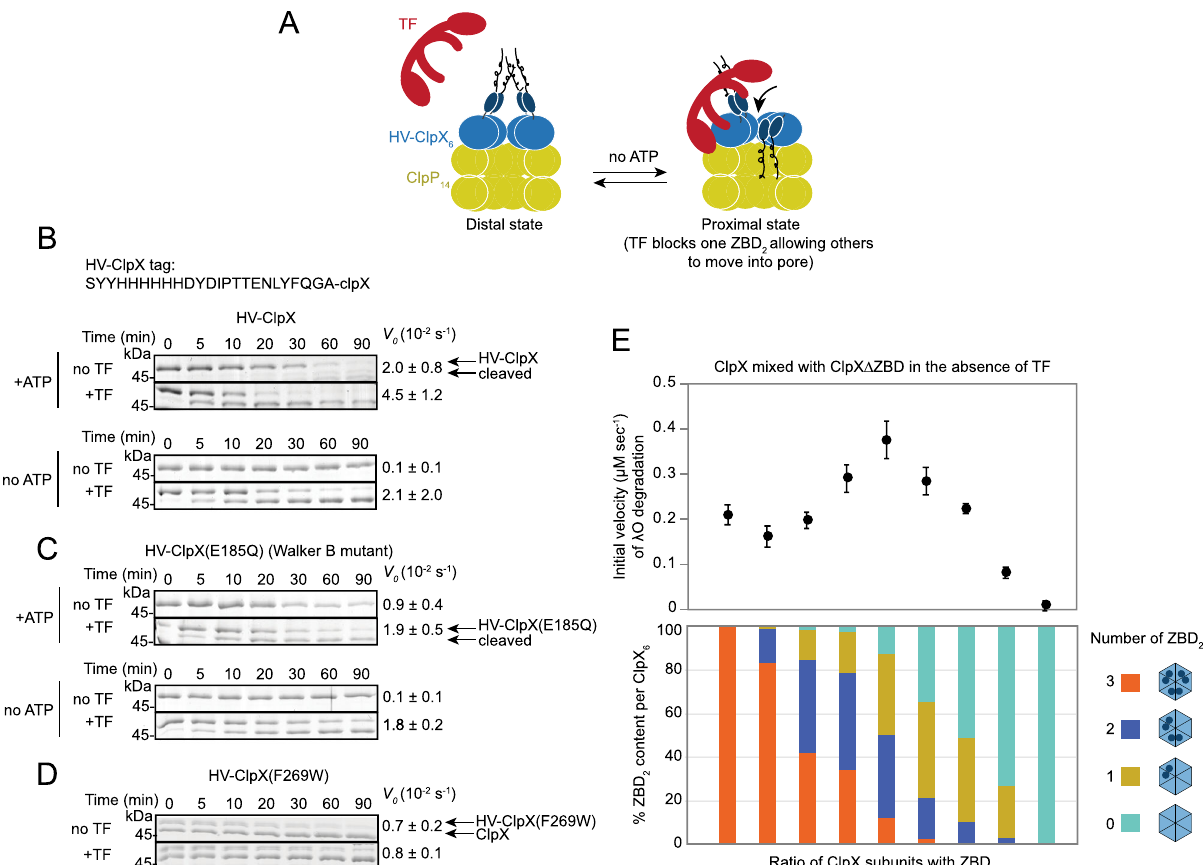
Fig. 3 TF enhances ClpXP-dependent degradation by modulating the movement of ZBD. A Model of the effect of TF on the change in the con fi guration of ZBD in ClpXP. Upon TF binding to a ZBD 2 , we propose that unbound ZBD 2 move from a distal con fi guration away from the ClpP catalytic chamber to a proximal con fi guration closer to the ClpP chamber. Hence, TF binding favors the proximal state of the unbound ZBD 2 s. B The enhanced clipping and degradation of N-terminally tagged ClpX by ClpP in the presence of TF. In vitro degradation assays using N-terminally tagged ClpX, HV-ClpX, in the absence or presence of TF and ATP. The HV-ClpX tag sequence is shown on the top. V 0 refers to the initial rate of disappearance of HV-ClpX. Standard deviations here and in ( C , D ) were calculated from at least three independent experiments. C Same as in ( B ) but using the ATPase-de fi cient Walker B HV- ClpX mutant. D Degradation assay in which the ClpXP complex was performed in the presence of ATP, then HV-ClpX(F269W) was added to the mixture. The rates shown are for the HV-ClpX(F269W) protein degradation. E Initial rates of λ O degradation in the presence of mixed ClpX:ClpX Δ ZBD complexes and ClpP. The calculated ratio of ClpX and ClpX Δ ZBD in each ClpX 6 complex varies depending on the mixing ratio and is shown in the lower panel (see “ Methods ” ). Error bars represent the standard deviations from n = 3 independent reactions. Source data are provided as a Source Data fi